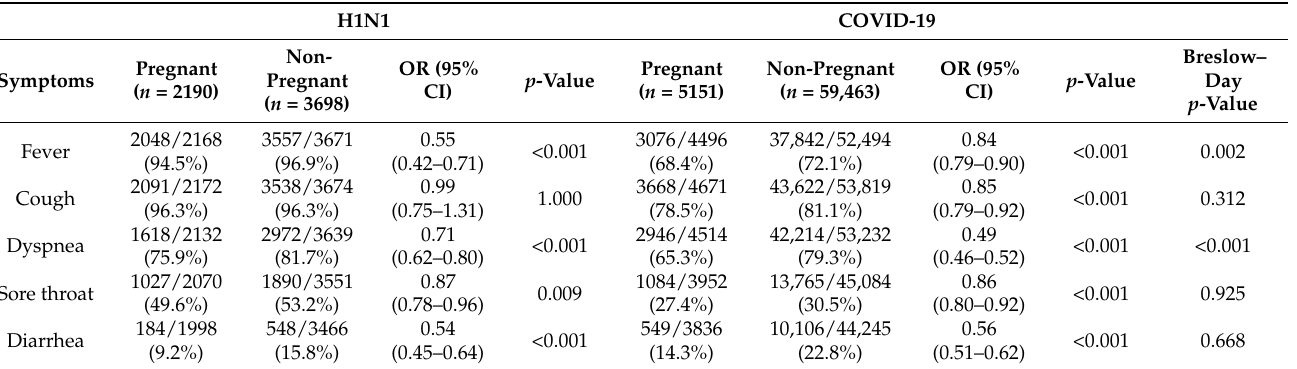
disease (9.7% vs. 17.4%, p < 0.001). According to the Breslow–Day test, this protection effect of pregnancy was higher during the COVID-19 pandemic (OR 0.75; 95% CI 0.62–0.89 vs. OR 0.51; 95% CI 0.46–0.57, p < 0.001 for Breslow–Day test). In order to avoid potential bias